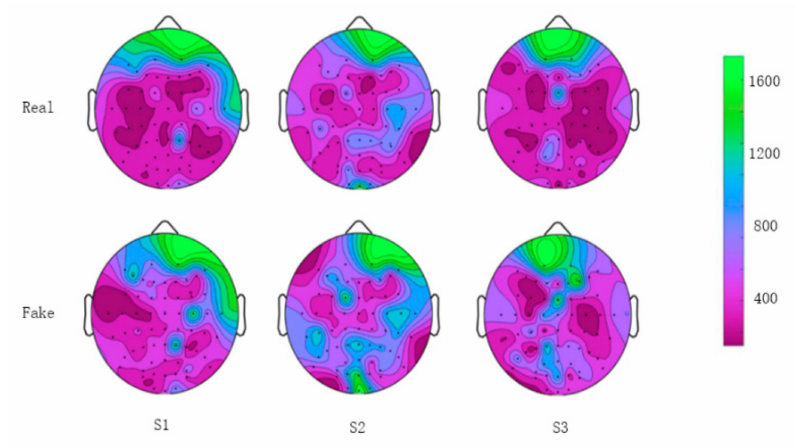
Figure 3. The average feature power on topographic maps.